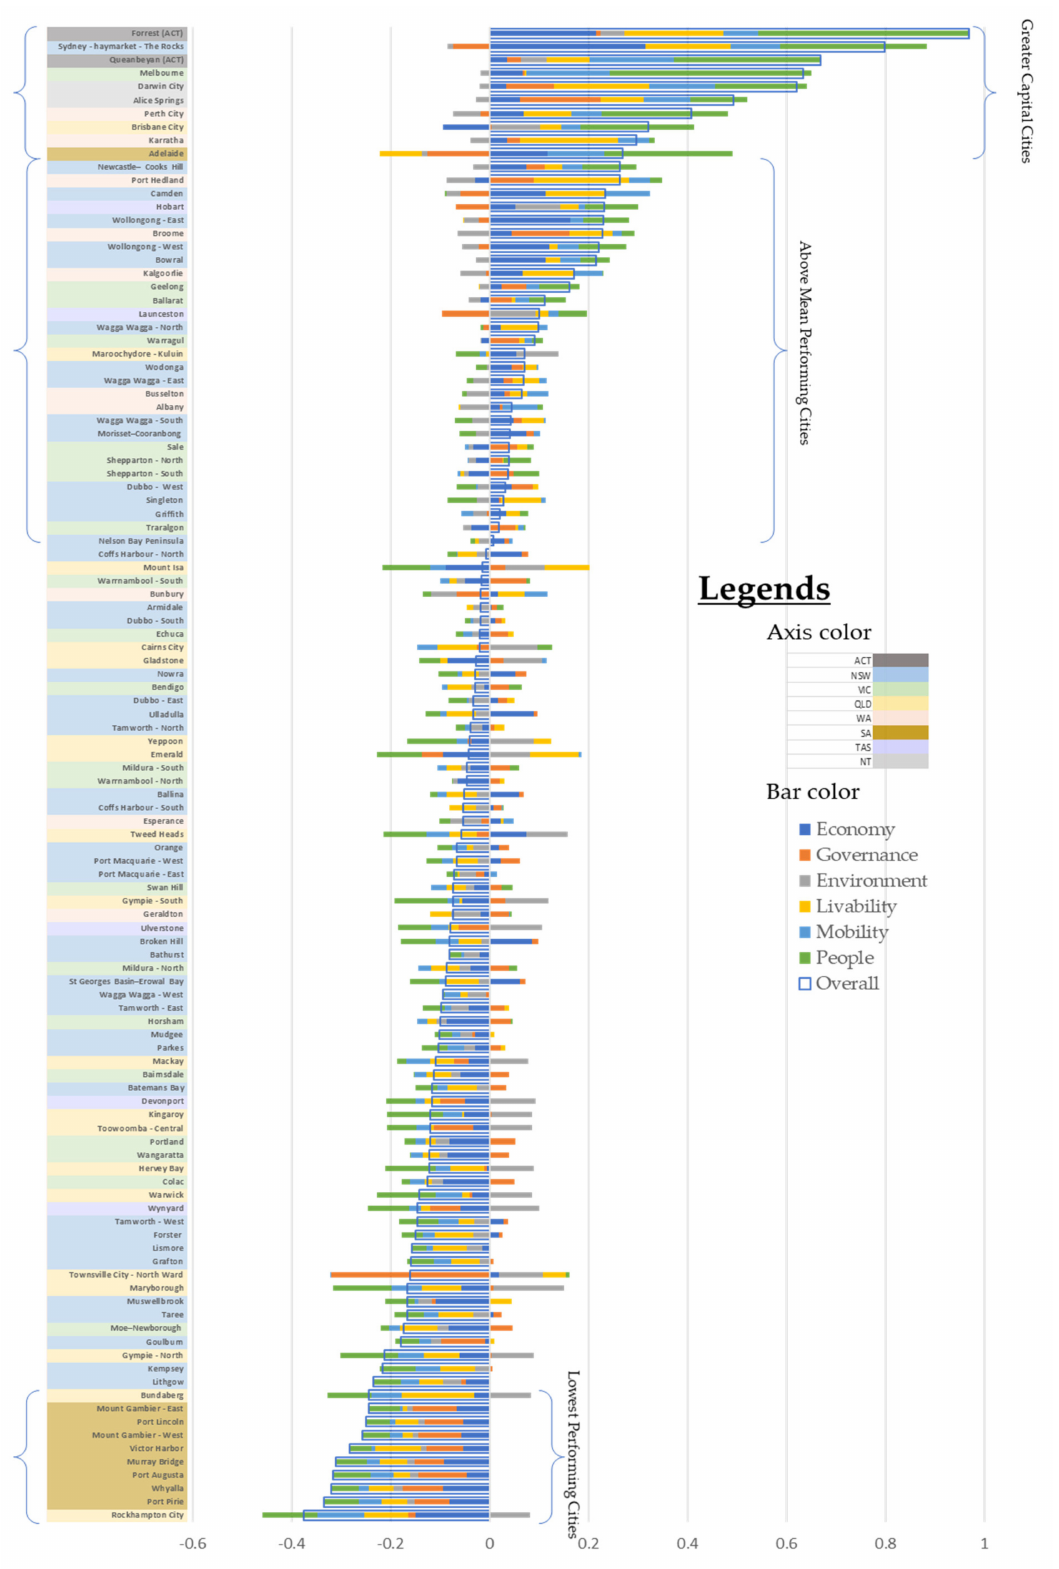
Figure 4. Smart score in descending order for 112